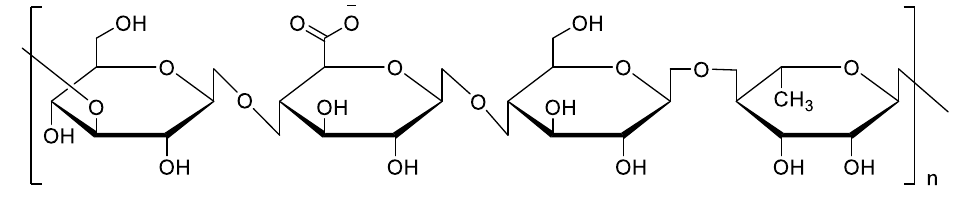
Figure 8. The structure of gellan.